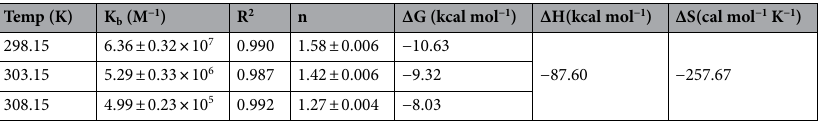
Table 2. Tabular representation of binding constant (K b ) and thermodynamic parameters like ΔH, ΔG, and ΔS for HSA-T-res system at three different temperatures, 298.15, 303.15, and 308.15 K.